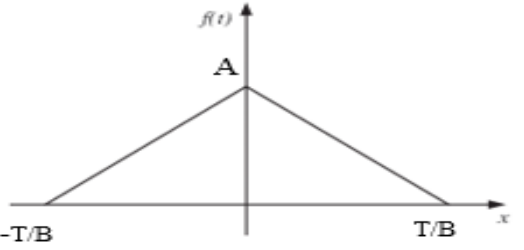
Figure 5. Symmetric triangular wave function to model the QRS components of an ECG signal.